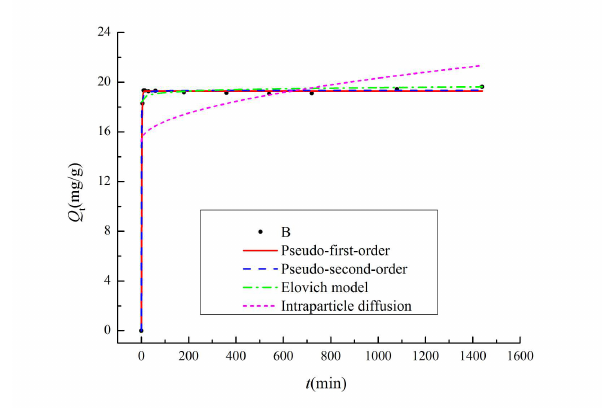
Figure 9. The adsorption kinetics of CB biochar for NO 3 − (650 ◦ C / 3